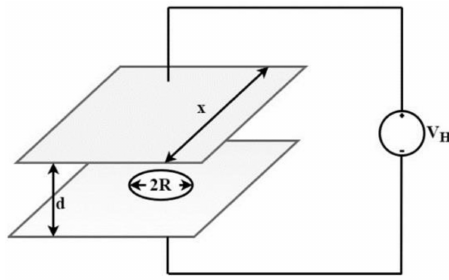
Figure 3. Calibration